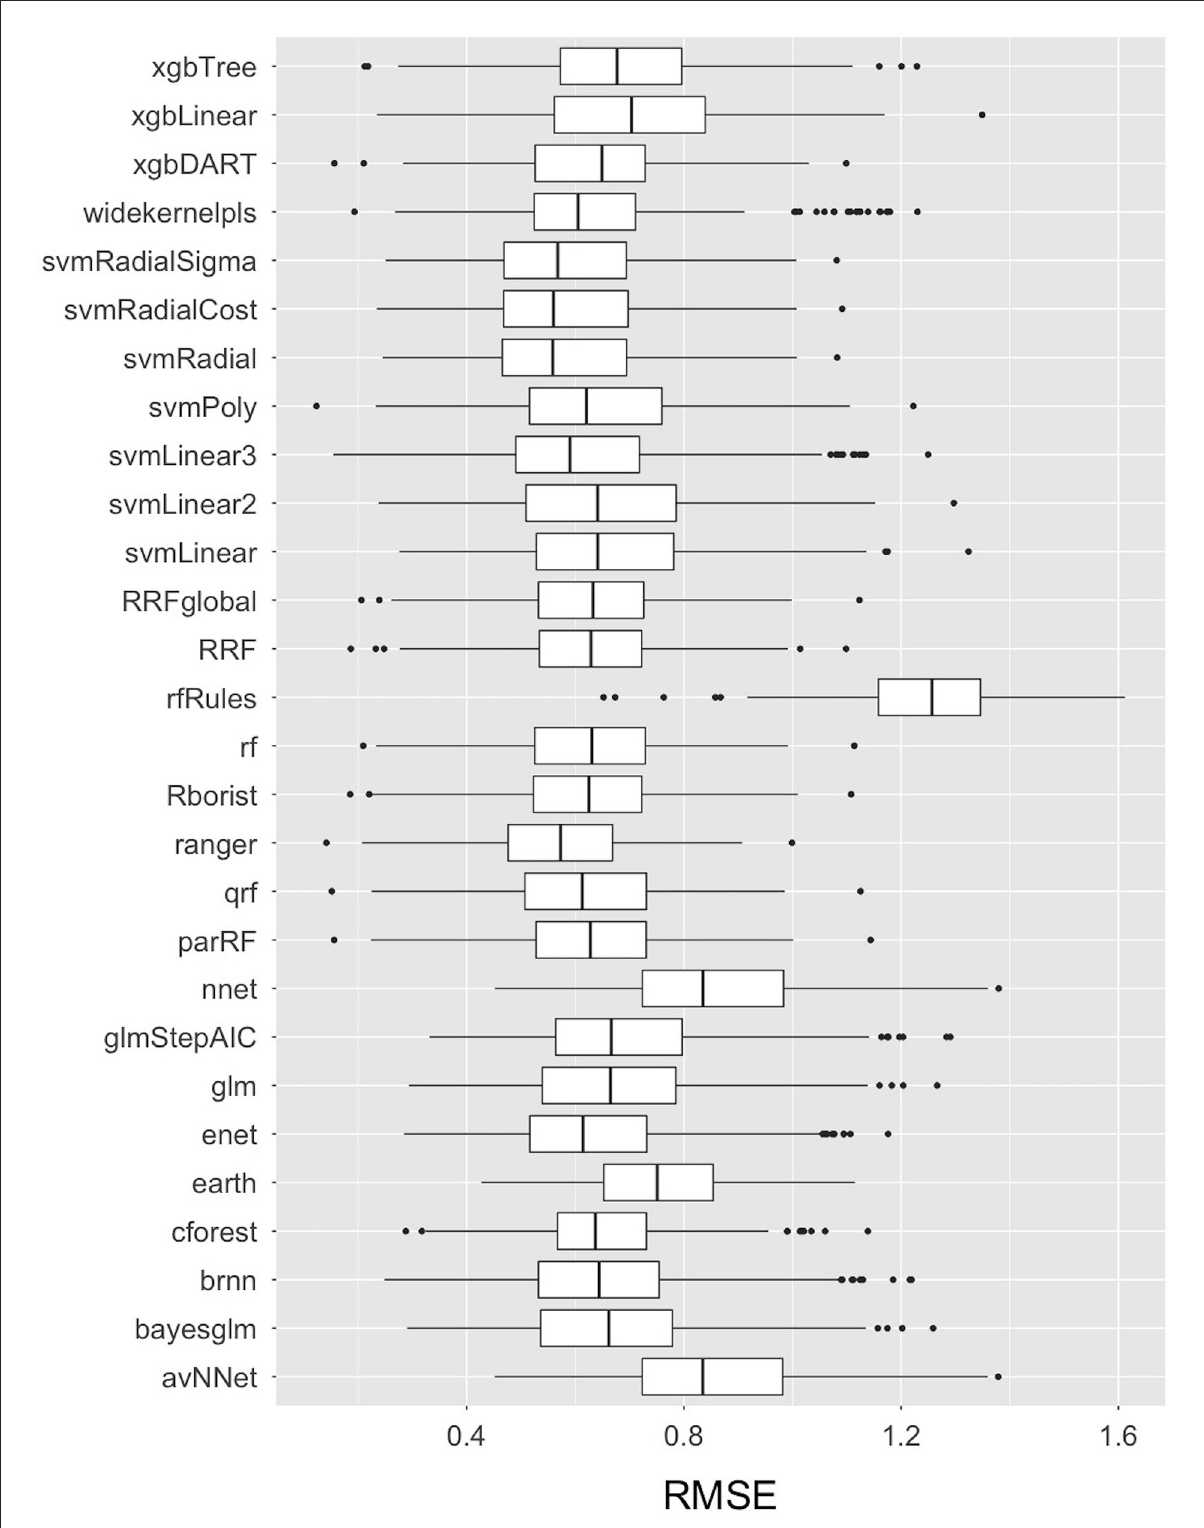
FIGURE4 Box-and-Whisker plots comparing the Root Mean Square Error (RMSE) values of the 28 base-learner independent machine learning algorithms used to train the data in predicting live E. coli levels in Dairy Effluent Management Systems. The plots display the median with a horizontal line, the 25th and 75th percentiles with the lower and upper box limits, the extreme observations with the bars, and the outlier data as dots. These RMSE values pertain to transformed